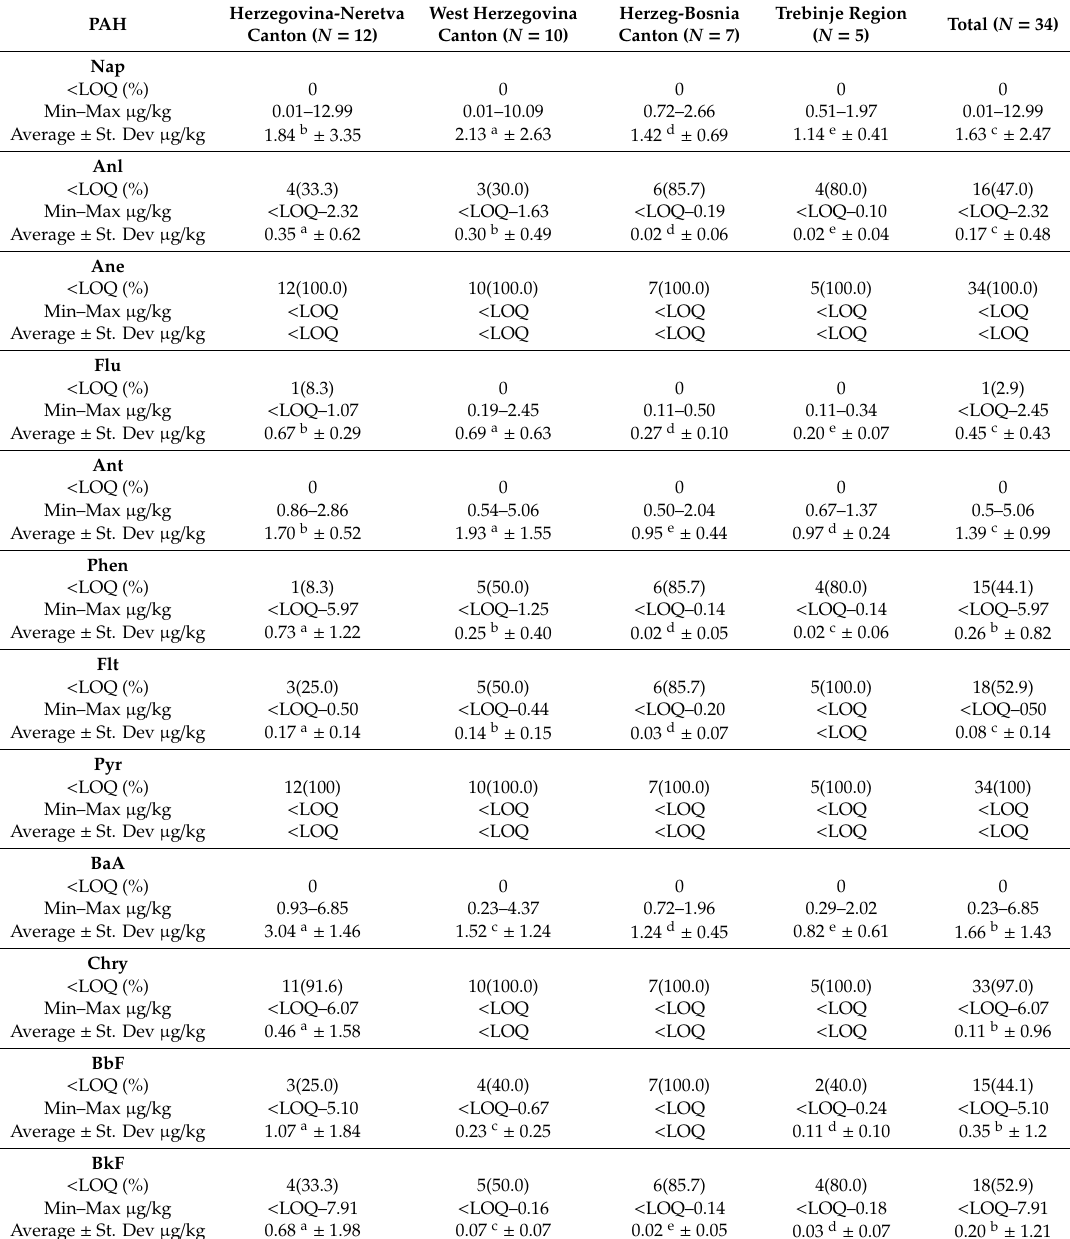
Table 1. PAH (polycyclic aromatic hydrocarbons) contents ( µ g / kg) in Hercegovaˇcki pršut . Herzegovina-Neretva Canton ( N =